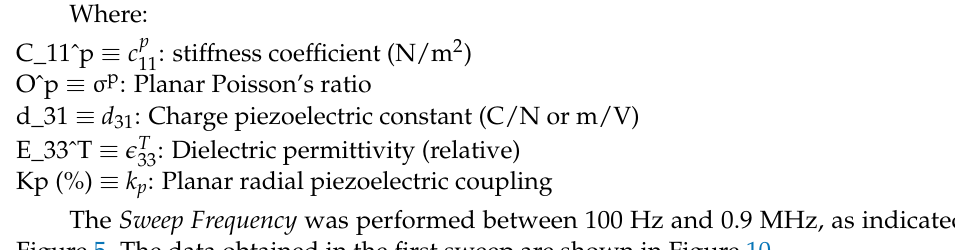
Figure 9. Virtual Instrument front